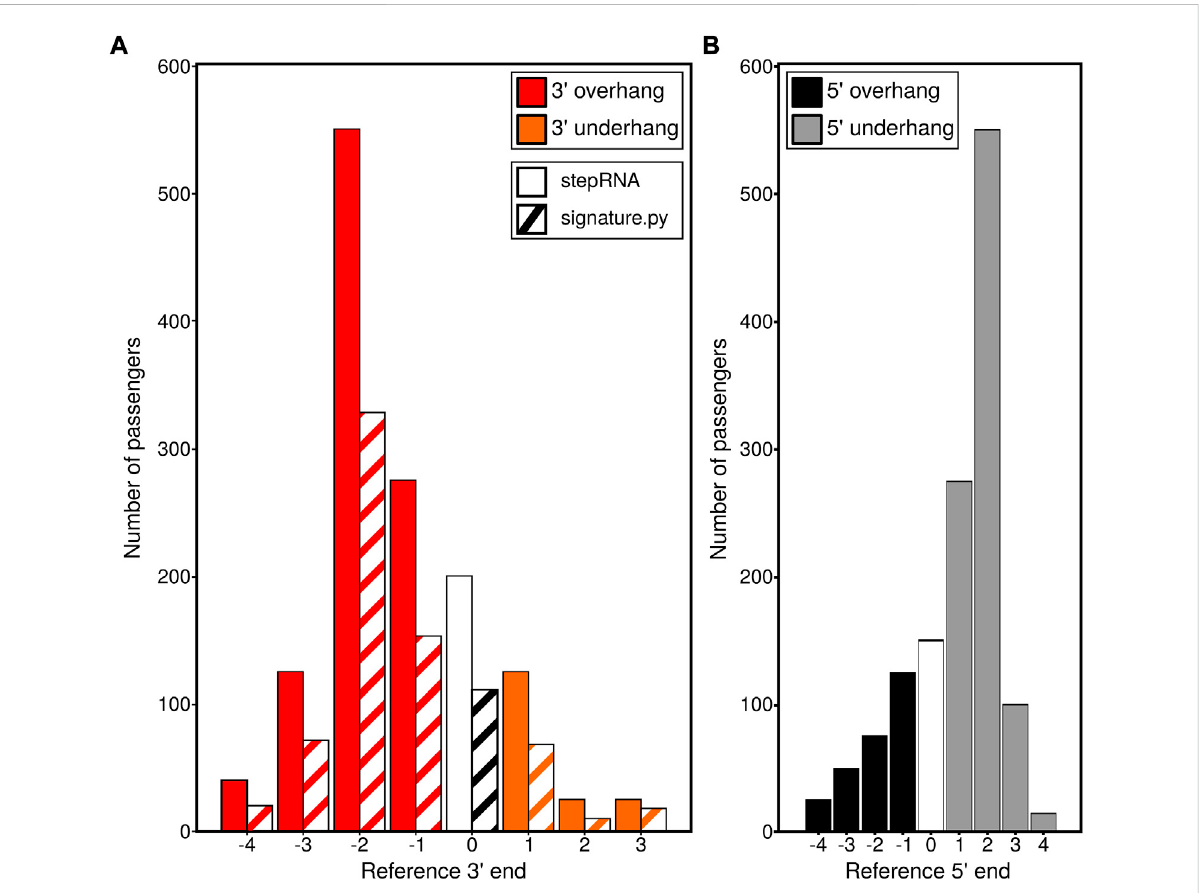
FIGURE 2 stepRNA outperforms the currently available tool signature.py on a simulated dataset. Simulated data were generated for File A (the reference sequence e.g. the predicted guide strand) and File B (the passenger strand) with known lengths, passenger numbers and overhang or underhang lengths. These data were run with stepRNA and signature.py. (A) Bar graphs show the number of predicted passenger strands for different overhang andunderhangdistances,identi fi edbystepRNA(solidbars)andsignature.py(hashedbars)atthe3 ′ referenceend.Anoverhangbythereference strandisrepresentedbyaredbar,areferencestrandunderhangbyanorangebarandabluntendisrepresentedbyawhiteorblackandwhitebar. (B) Bar graphs showing the 5 ′ reference end counts for the distancesidenti fi ed by stepRNA n.b. signature.py only provides3 ′ reference end information and there is no data for the 5 ′ end. A reference overhang is represented by black bars, a reference underhang by grey bars and a blunt end is represented by a white